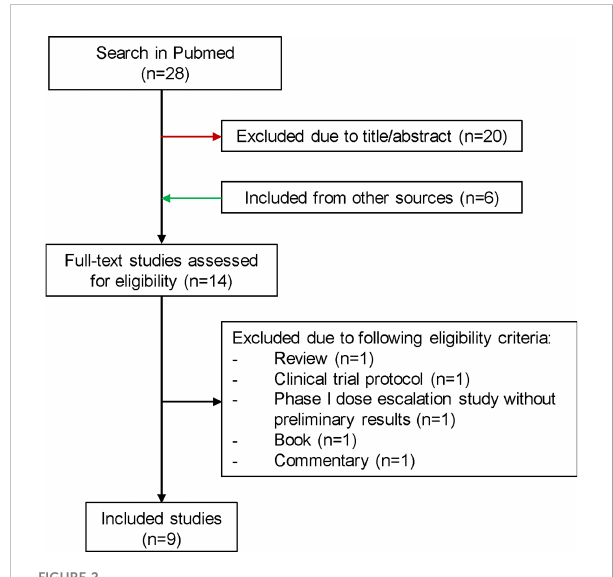
FIGURE 2 Flowchart for the selection process of published studies for preoperative SRS. SRS, stereotactic